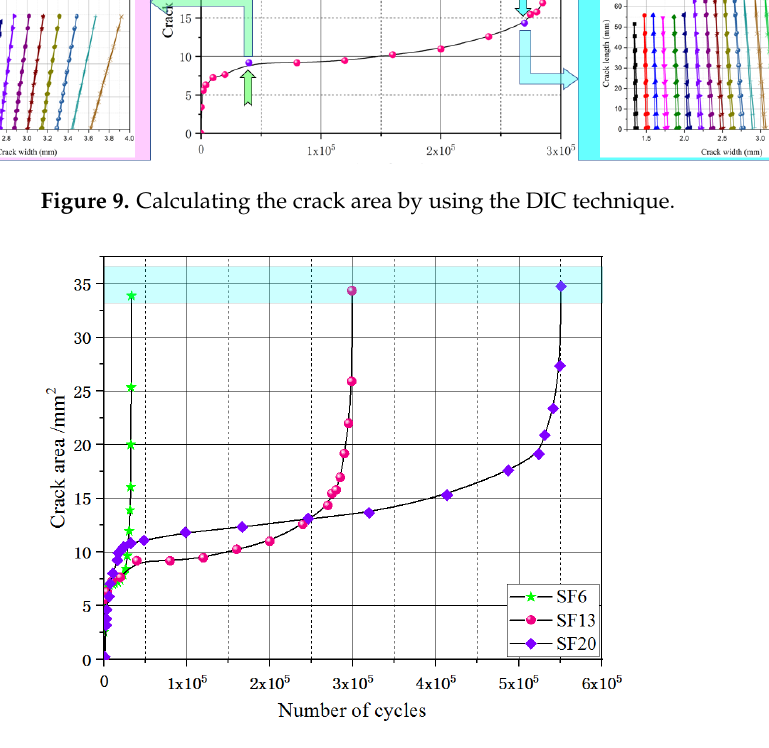
Figure 10. Relationship between the crack area (A) and number of cyclic loads